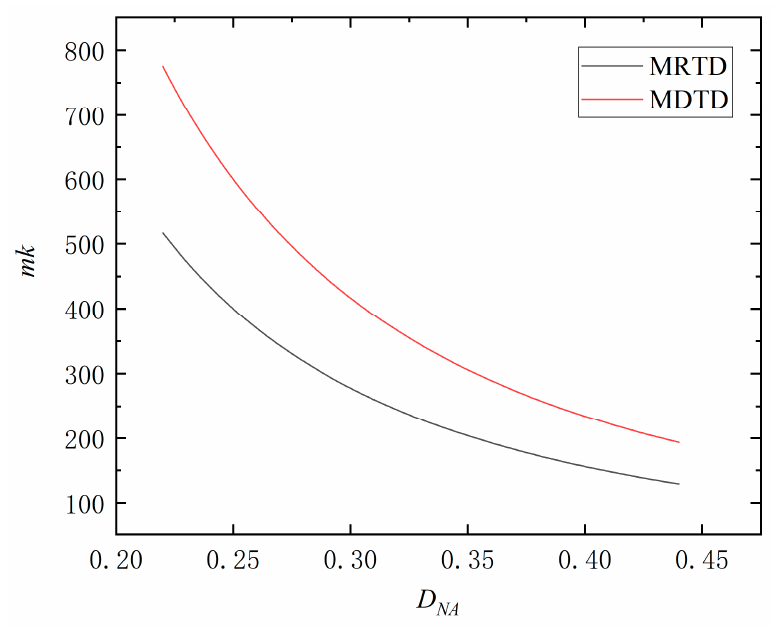
Figure 6. Relationship between system temperature resolution and D NA .